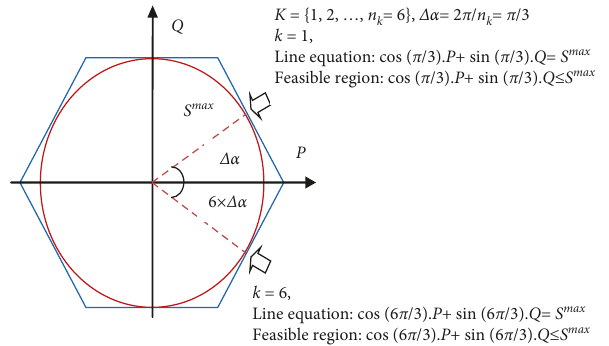
Figure 2: The proposed linearization method for circular in- equality [34]. Table 2: The values of the second and third WSI formulation in different values of P L , Q L , and V . (P L , Q L ) in p.u. (0.1, 0) (0.07, 0.07)